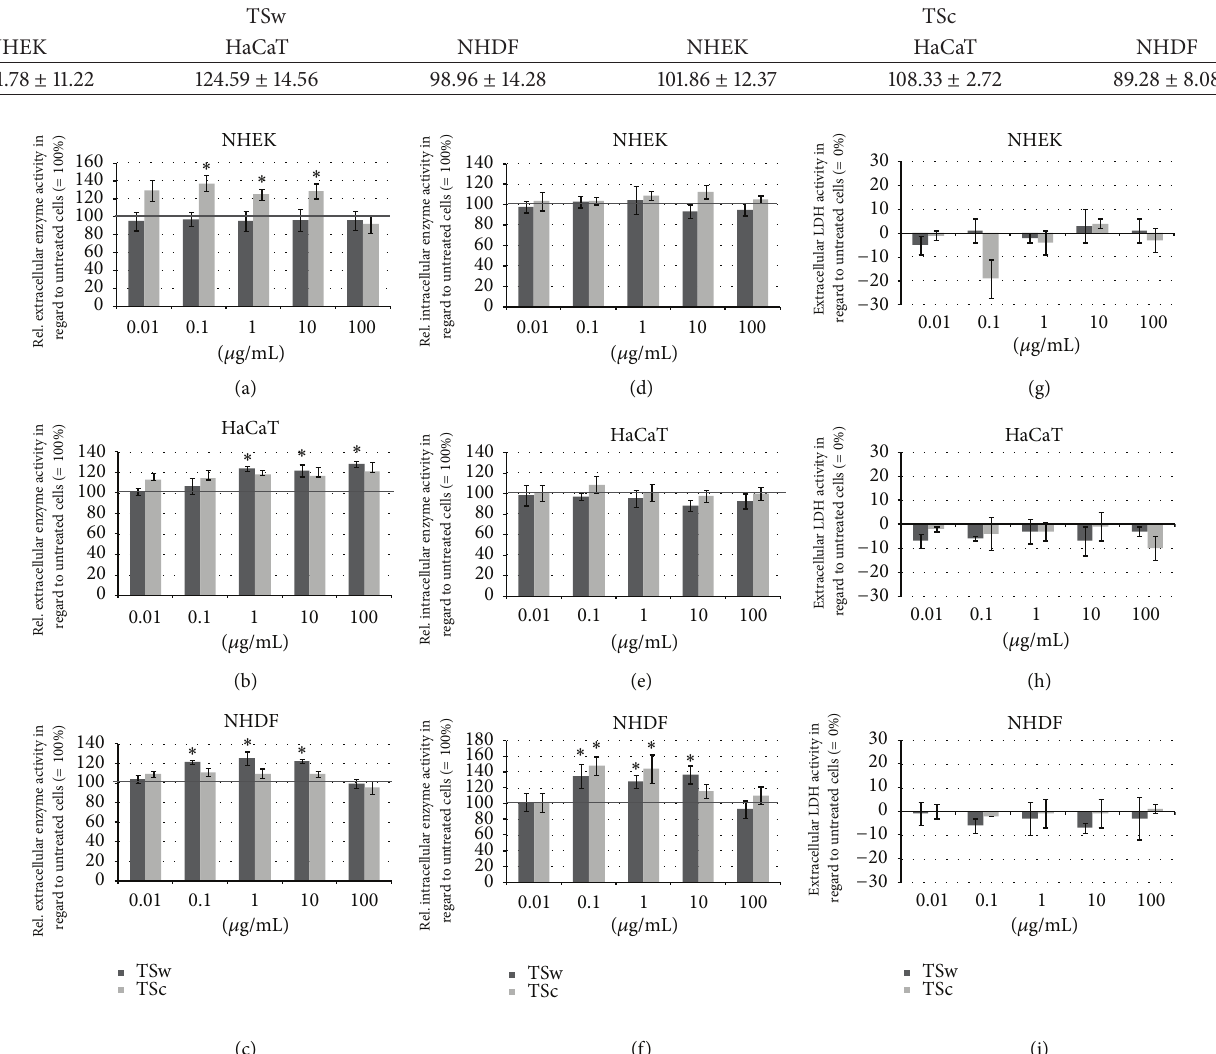
Table 2: Energy status of NHEK, HaCaT keratinocytes, and NHDF after incubation with 10 𝜇 g/mL Tamarind xyloglucans TSw and TSc. Shown are mean values ± SD of 𝑛 = 8 replicates of two independent experiments.